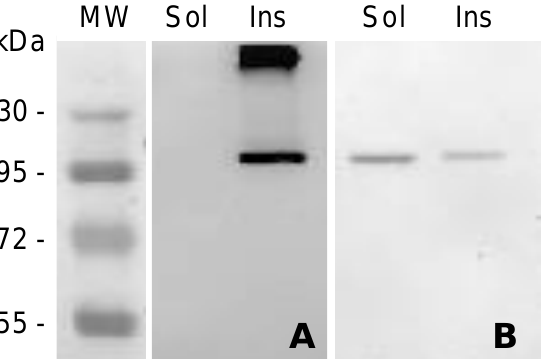
Figure 2. Solubility of MVP-H6 produced in cultures of E. coli cells induced with 1 mM IPTG, either for 3 h at 37 °C ( A ) or o/n at 20 °C ( B ). After obtaining soluble (Sol) and insoluble (Ins) cell fractions, they were submitted to SDS-PAGE and further Western blot, developed with an anti-His monoclonal antibody.